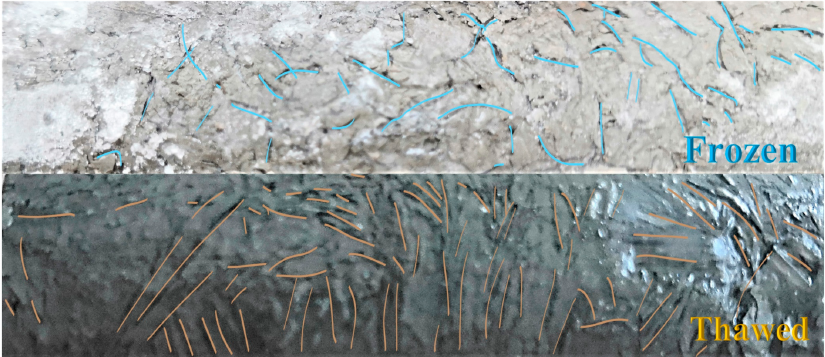
Figure 9. Freeze–thaw action influence on sample surface. Fissures are highlighted in blue and yellow for frozen and thawed soft clay, respectively.